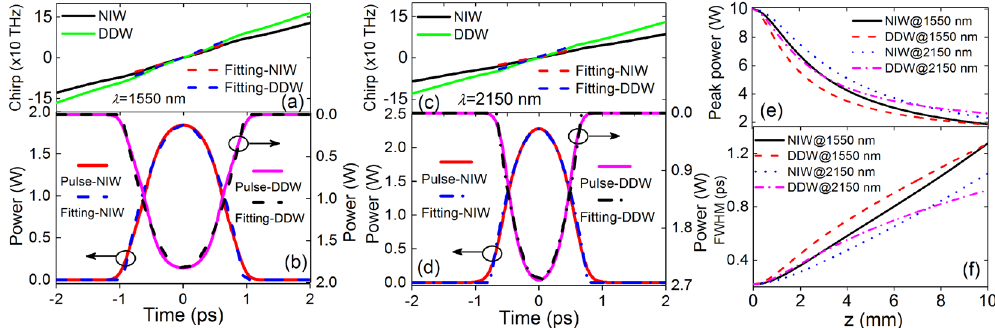
Figure 5. ( a ) Chirp profiles (solid curves) and their linear fits (dashed curves) for NIW (black and red curves) and DDW (green and blue curves) at 1550 nm. ( b ) Output pulse waveforms (solid curves) and their parabolic fits (dashed curves) for NIW (red and magenta curves) and DDW (blue and black curves) at 1550 nm. ( c ) Chirp profiles (solid curves) and their linear fits (dashed curves) for NIW (black and red curves) and DDW (green and blue curves) at 2150 nm. ( d ) Output pulse waveforms (solid curves) and their parabolic fits (dash-dotted curves) for NIW (red and blue curves) and DDW (magenta and black curves) at 2150 nm. ( e ) The peak power of propagating pulses for NIW (black solid curves) and DDW (red dashed curves) at 1550 nm, and NIW (blue dotted curves) and DDW (magenta dash-dotted curves) at 2150 nm. ( f ) The FWHM of propagating pulses, for NIW (black solid curves) and DDW (red dashed curves) at 1550 nm, and NIW (blue dotted curves) and DDW (magenta dash-dotted curves) at 2150